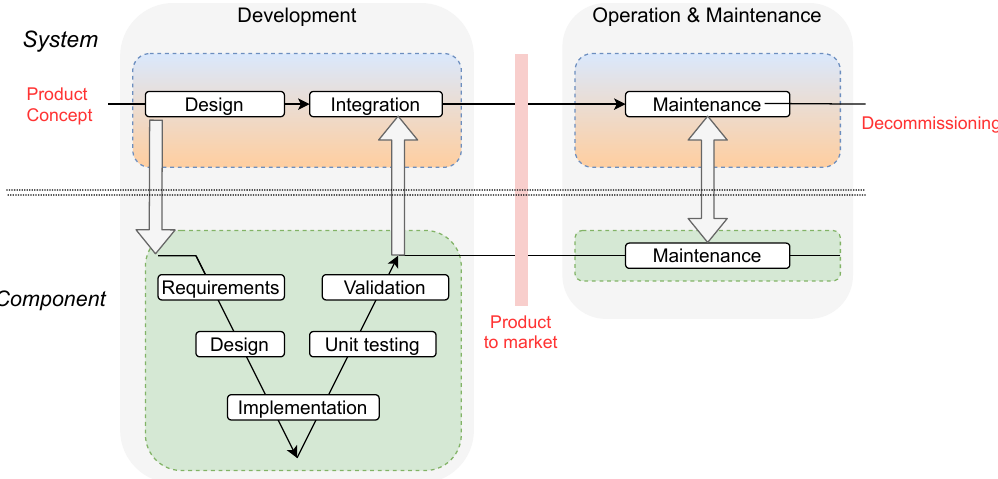
Figure 3. IIoT system and components of a simplified